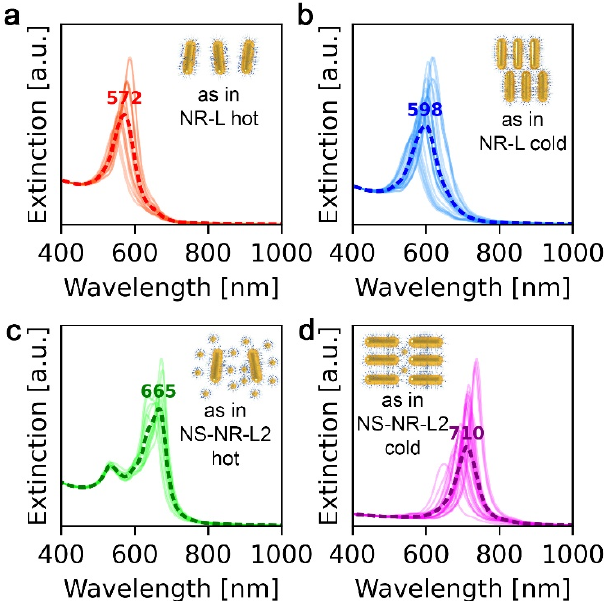
Figure 4. Results of FDTD simulations. ( a ) NRs arranged in a single layer, loosely packed. This simulation corresponds to UV–vis spectra of NR-L and NR-NS-L1 materials acquired at 120 °C (shown in Figure 3). ( b ) Multiple layers of NRs with the noncollinear arrangement of NRs in neighboring layers. This simulation corresponds to UV–vis spectra of the NR-L system acquired at 30 °C and partially corresponds to UV–vis spectra of the NR-NS-L1 system acquired at 30 °C. ( c ) NRs with above 10 nm side-to-side distance and abundant NSs, this simulation corresponds to UV–vis spectra of the NR-NS-L2 system acquired at 120 °C. ( d ) Multiple layers of NRs with the colinear arrangement of NRs in consecutive layers. NSs are present in between NRs. This simulation corresponds to UV–vis spectra of the NR-NS-L2 system at 30 °C.